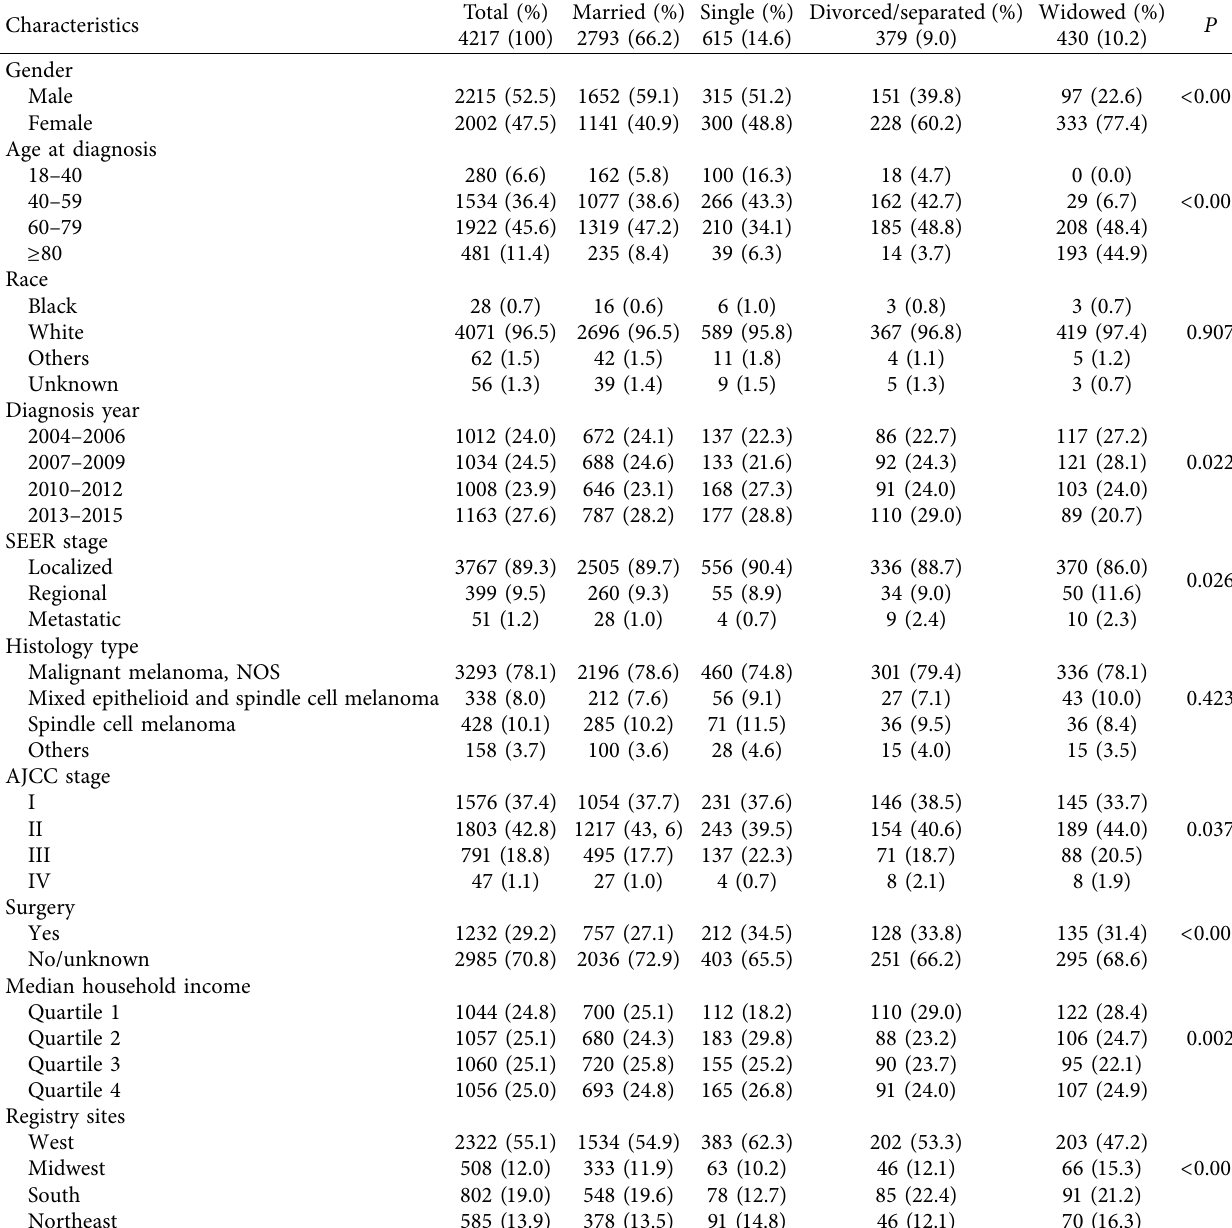
Table 1: Baseline characteristics of uveal melanoma patients in the SEER database eligible in this study.